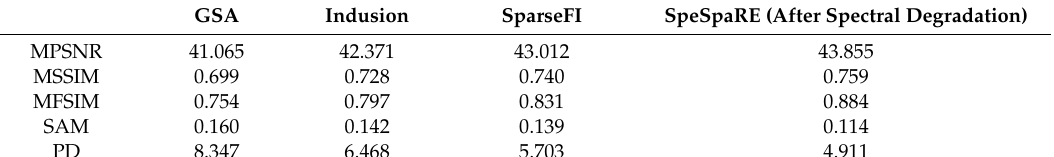
Table 2. Spatial assessment of our proposed method and pan-sharpening methods on Cuprite dataset.